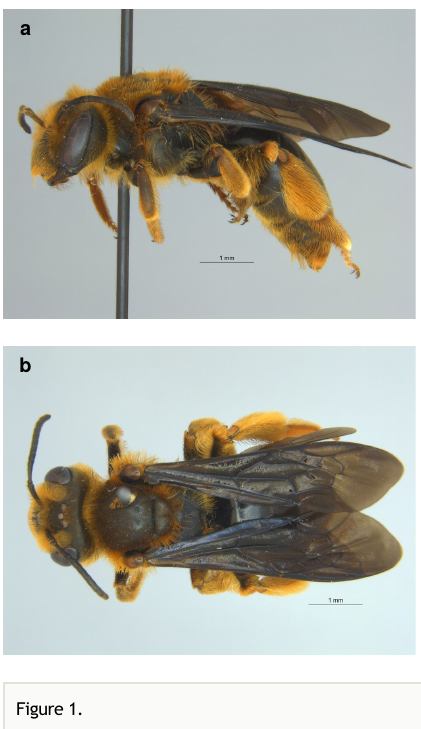
Figure 1. Female Andrena ( Melandrena ) obscuripennis. a : Lateral view. b : Dorsal b.